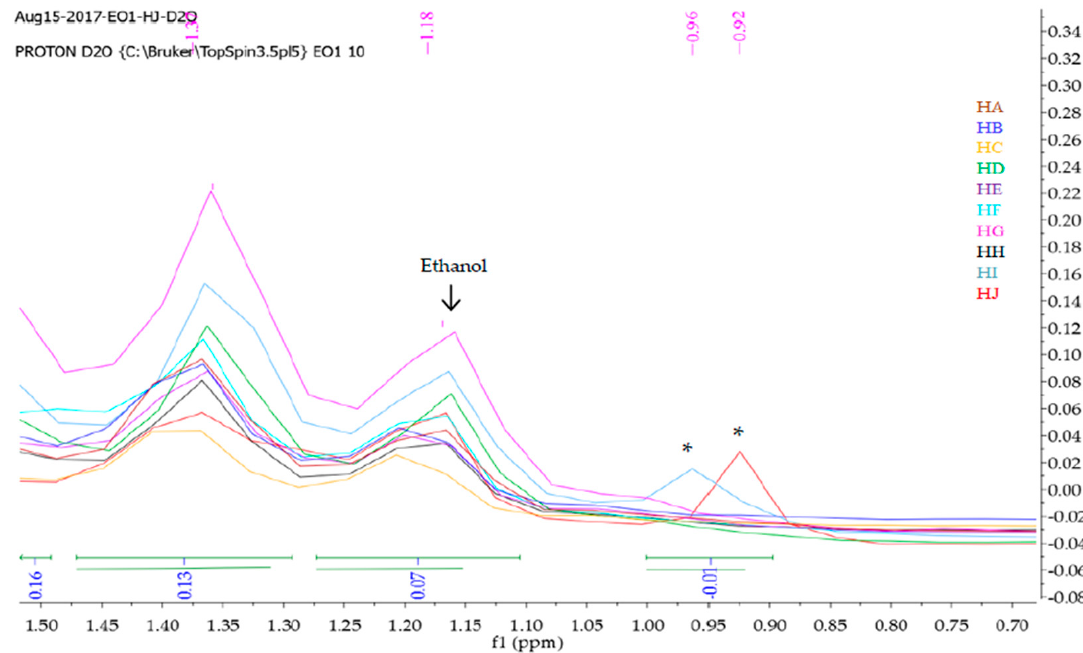
Figure 2. Fingerprints of superimposed and binned 1 H-NMR spectra in D 2 O at region 1.50–0.75 ppm, using Mnova 12 NMR software. * Variable Importance in Projection (VIP) chemical markers resonating at 0.92 and 0.96 ppm.